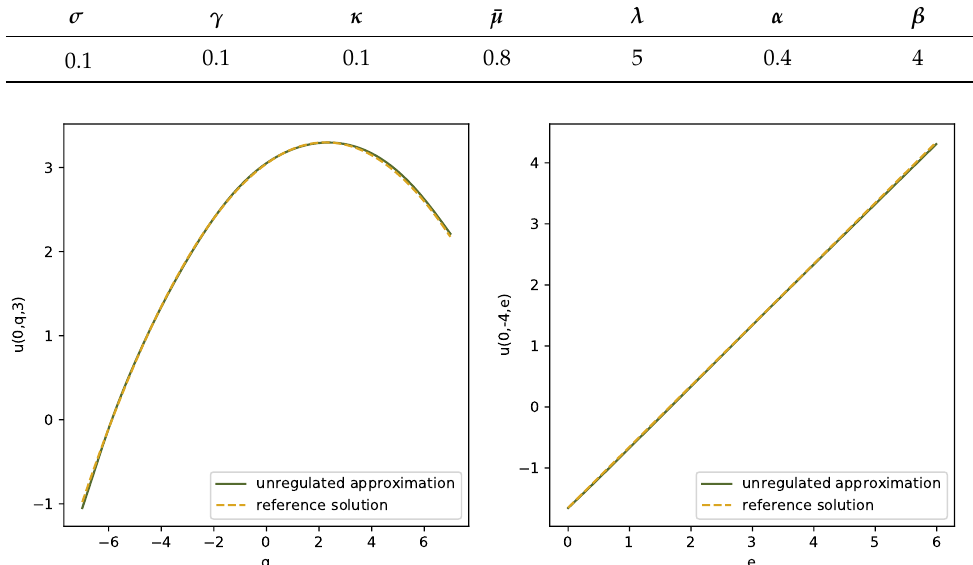
Figure 6. Solution of the unconstrained credit optimization problem for q ∈ [ − 7,7 ] , e = 3 ( left ) and q = − 4, e ∈ [ 0,6 ] ( right ) with the DNN-algorithm ( green ) and reference solution ( orange ).